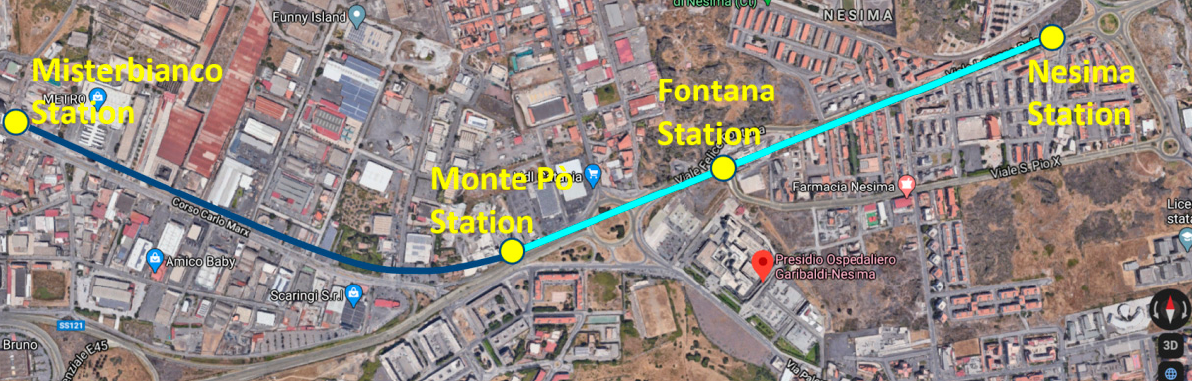
Figure 2. The Nesima-Misterbianco segment under investigation.